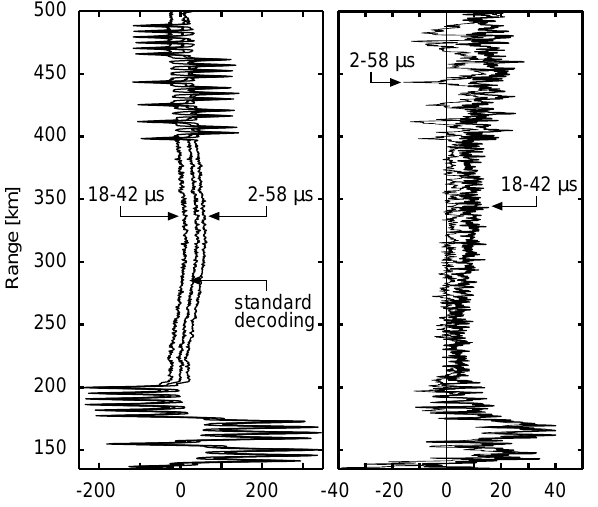
Fig. 9. Left: The standard deviations of the 30- µ s lag profiles in the left-hand panel of Fig. 8. Right: The ratio of the standard deviations obtained by standard decoding and inversion with a lag range of 2– 58 µ